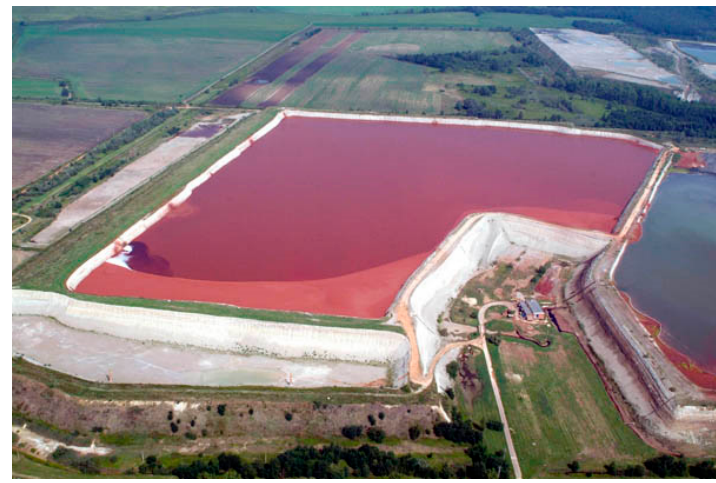
Figure 2. Planform of red mud (RM) yard disposed by damming stockpiling [2].